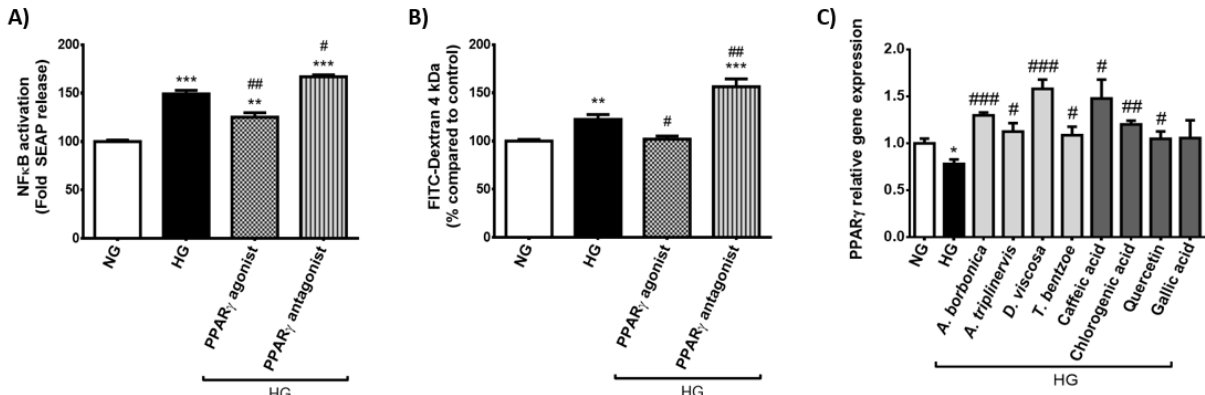
Figure 7. Effect of PPAR γ agonist and antagonist on the inflammatory and permeability alterations caused by hyperglycemic condition in cerebral endothelial cells. Cells were exposed to normoglycemic condition (NG) or hyperglycemic condition (HG) in presence or not of PPAR γ agonist or antagonist (10 µ M) for 3 h. Relative NF κ B/SEAP activity ( A ) and relative endothelial permeability ( B ) were determined by Quanti-Blue and FITC-dextran assays, respectively, and expressed as the percentage of the control NG condition. In parallel, cells were exposed to normoglycemic condition (NG) or hyperglycemic condition (HG) in presence or not of each polyphenol-rich plant extract (10 µ M GAE) or a pure polyphenol (10 µ M) for 3 h. Relative expression of PPAR γ gene was measured by RT-qPCR and normalized to GAPDH gene expression ( C ). Data are means ± SEM of three independent experiments (three cellular passages). *: p < 0.05, **: p < 0.01 and ***: p < 0.005 as compared to NG; # : p < 0.05, ## : p < 0.01 and ### : p < 0.005 as compared to HG.